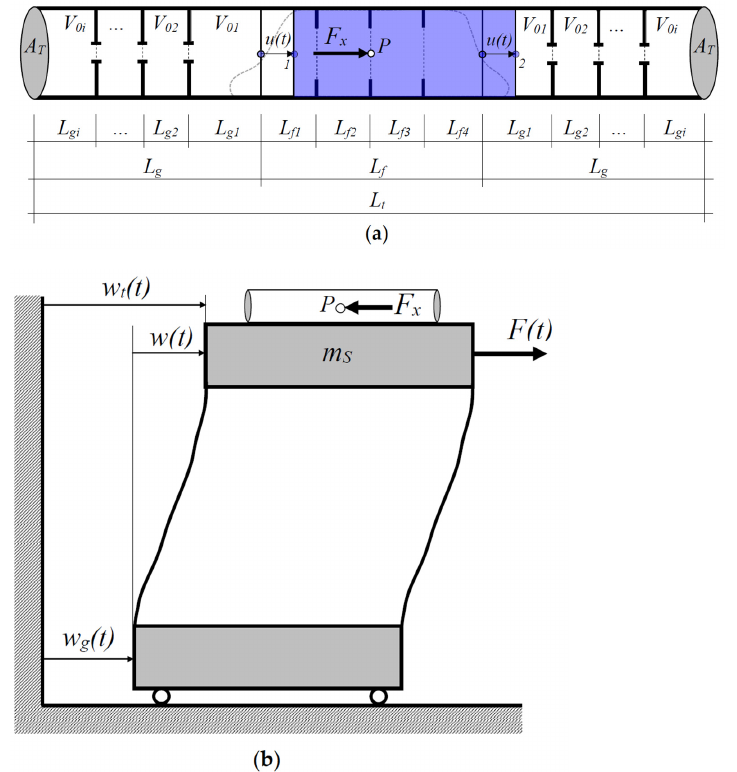
Figure 2. Free body diagrams of the mechanical model: ( a ) single tube SA-TLGD under horizontal floor excitation; ( b ) SDOF-main system under combined seismic w g ( t ) and force excitation F ( t ) with horizontal interaction force F x from the SA-TLGD dynamics.